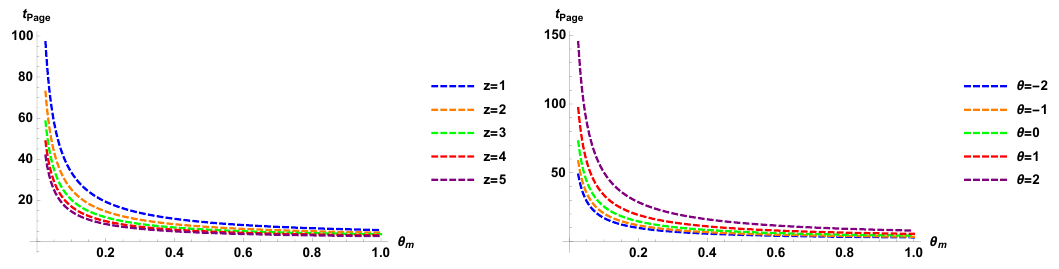
Figure 7 . Page time when the matter is described by a HV QFT d +2 with θ m 6 = 0 as a function of θ m : ( Left ) for d = 2 , θ = 0 and different values of z . ( Right ) for d = 3 , z = 1 and different values of θ . Here we set A = V = r = 1 and G = 0 . 001 d h N,r